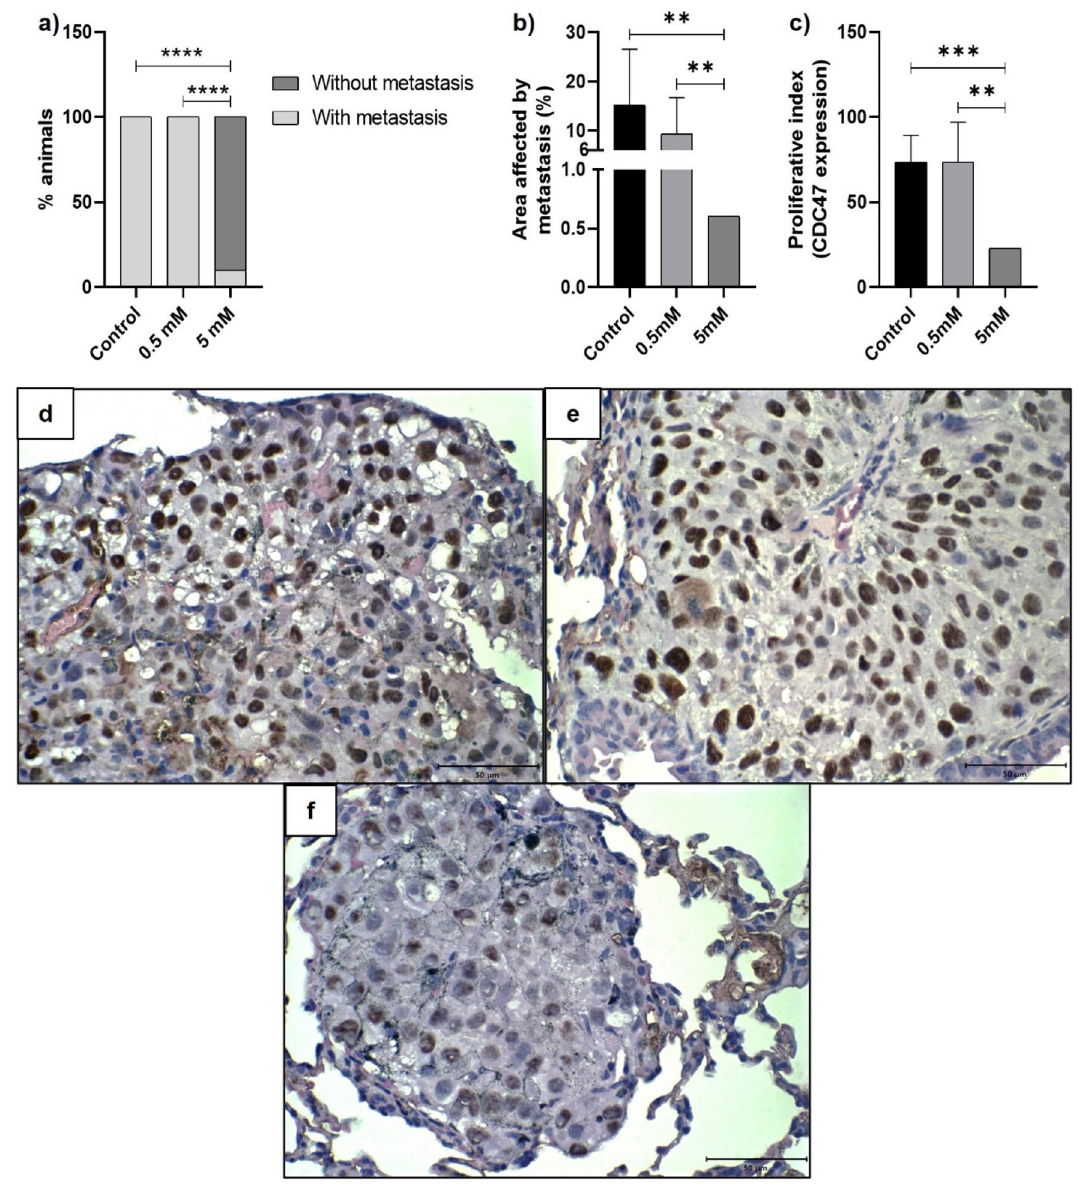
Figure 6. Histopathological and immunohistochemical parameters of pulmonary metastases from metformin- treated or untreated B16-F10 cells in C57BL/6 mice. ( a ) Frequency of pulmonary metastases. Fisher’s exact test. ( b ) Measurement of the pulmonary area affected by metastases. One-sample t-test. ( c ) Proliferative index of pulmonary metastases. One-sample t-test. **p < 0.01; ***p < 0.001; **** p < 0.0001. ( d – f ) Lung tissues, collected 21 days after inoculation of B16-F10 cells, were submitted to immunohistochemistry technique for CDC47 identification. Nuclear immunoexpression was evaluated in 500 neoplastic cells, allowing the determination of the mean proliferative index. ( d ) Cells untreated with metformin; ( e ) Cells treated, in vitro , with 0.5 mM of metformin; ( f ) Cells treated, in vitro, with 5 mM of metformin. ×60. Scale bar: 50